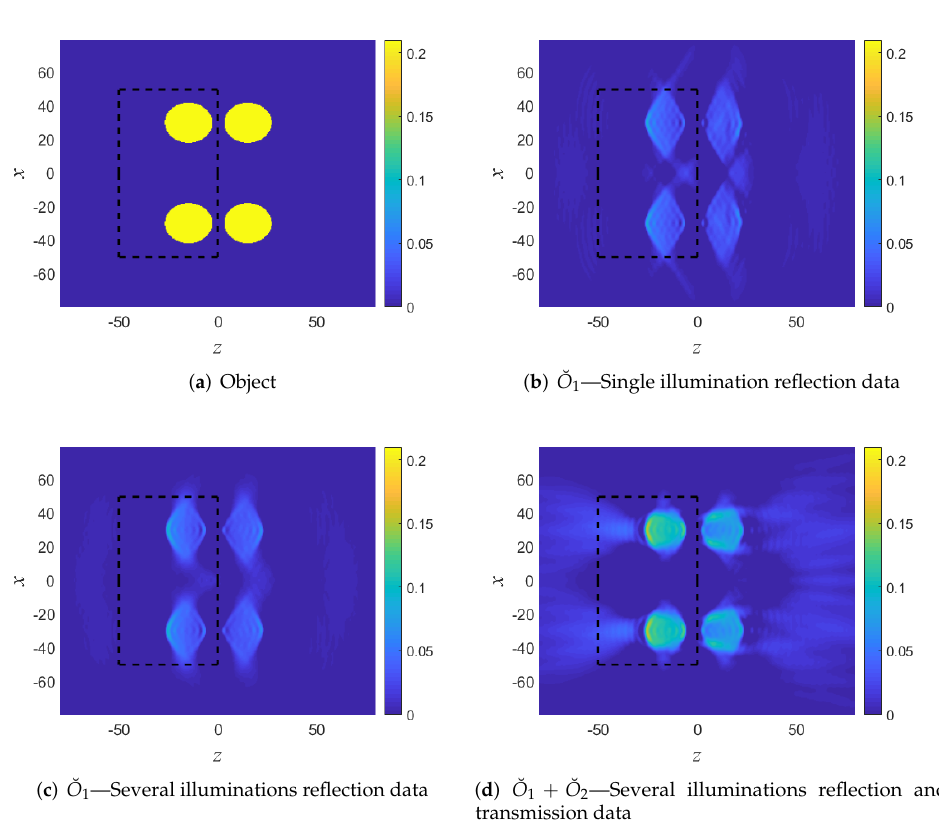
Figure 10. Numerical example B. ( a ) The object function. ( b ) Reconstruction using single illumination and reflection data. ( c ) Reconstruction using several illuminations and reflection data. ( d ) Recon- struction using several illuminations and reflection and transmission data. The DoI is illustrated in a black rectangle.